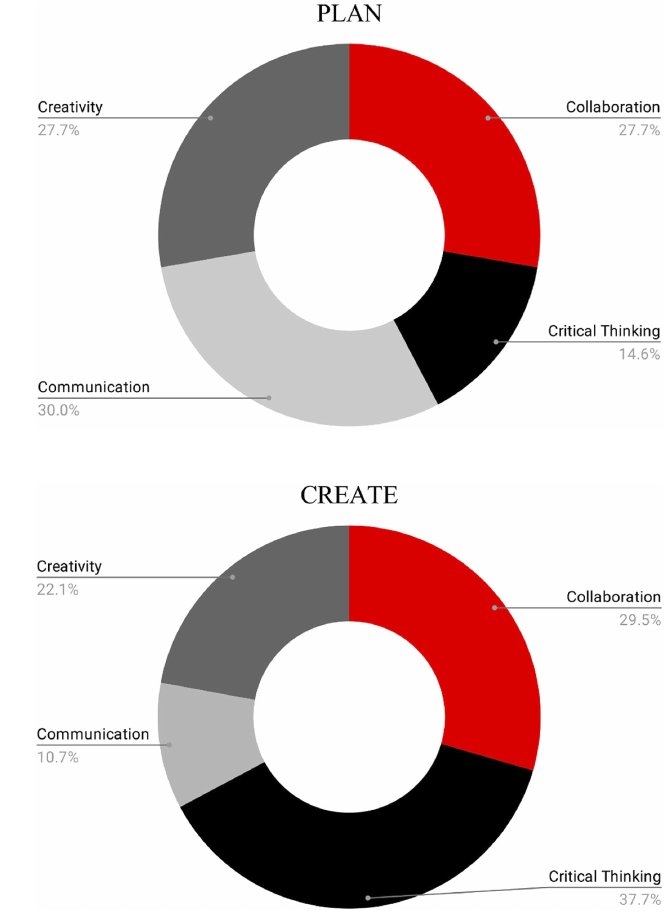
Figure 8. Percentages of 4Cs reported by students in year two at the create step of the EDP